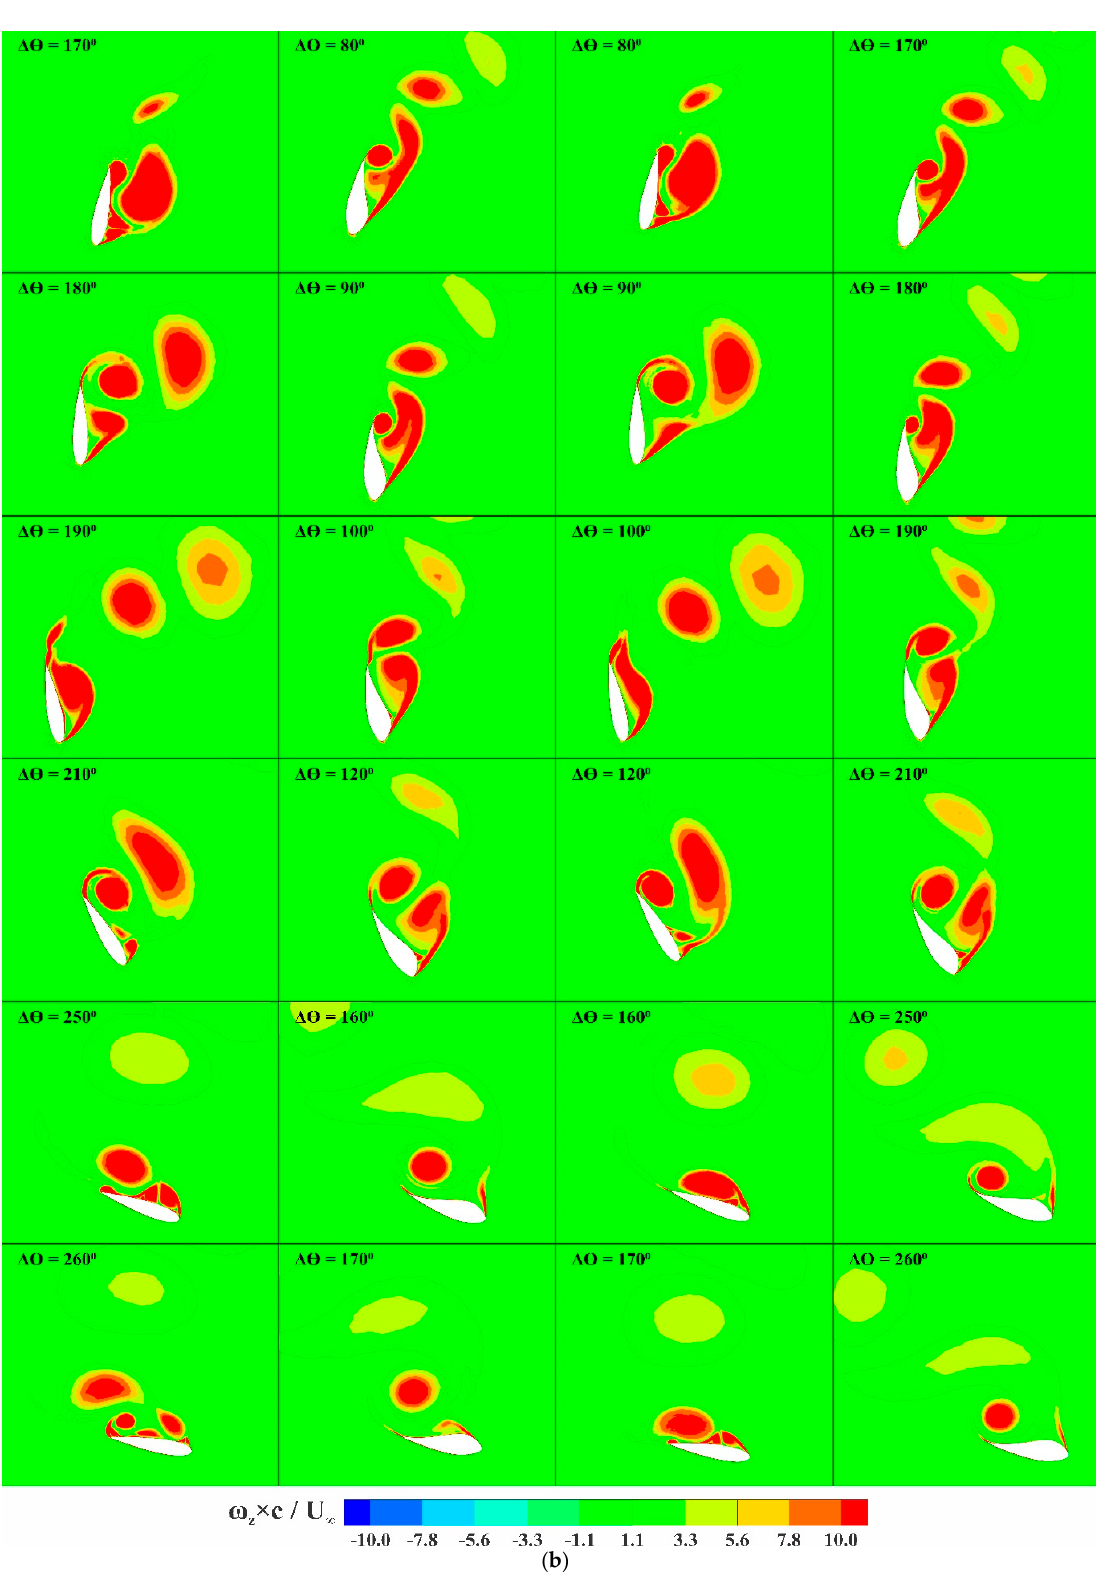
Figure 9. ( a ) Vorticity contours of NSA-1 and NSA-2 for zero rotational angle ( Δθ = 0°, see Figure 1) at TSR = 1.5; column 1: NSA-1, NACA0018; column 2: NSA-1, S815; column 3: NSA-2, NACA0018; column 4: NSA-2, S815. ( b ) Continued. The vortical structures of NACA0018 and S815 for different arrangements in the